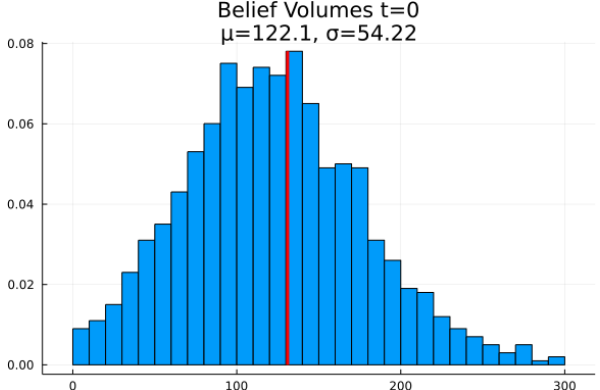
Figure 8. Initial belief ore histogram. The figure shows the distri- bution of massive ore volumes in the initial belief ensemble. The vertical line shows the actual volume of ore in the illustration